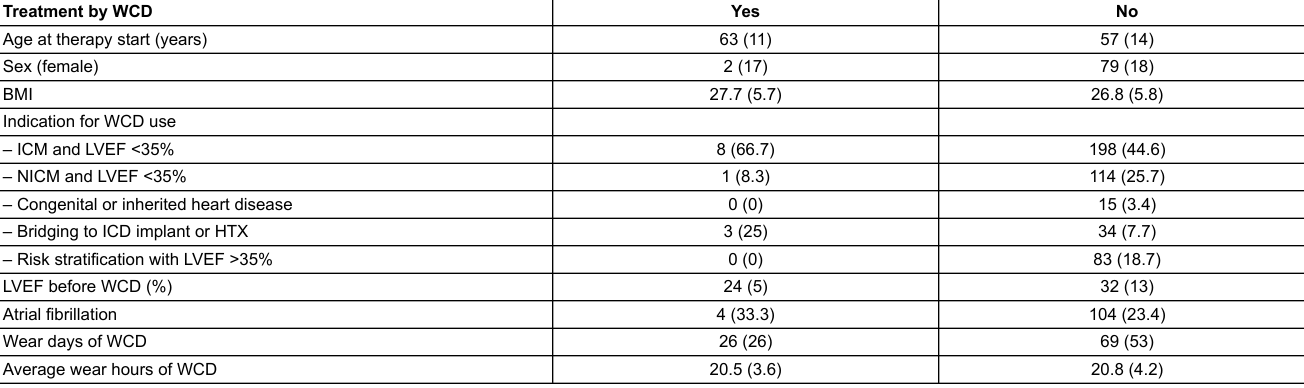
Table S1: Comparison of patients with and without wearable cardioverter defibrillator treatment. Treatment by